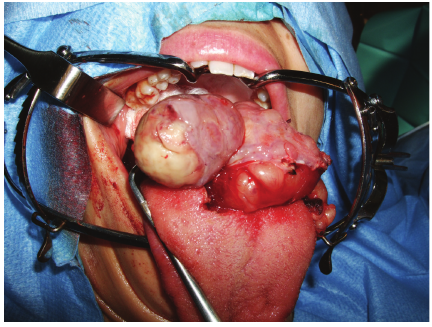
Figure 3: Per-operative aspect of the tongue schwannoma.